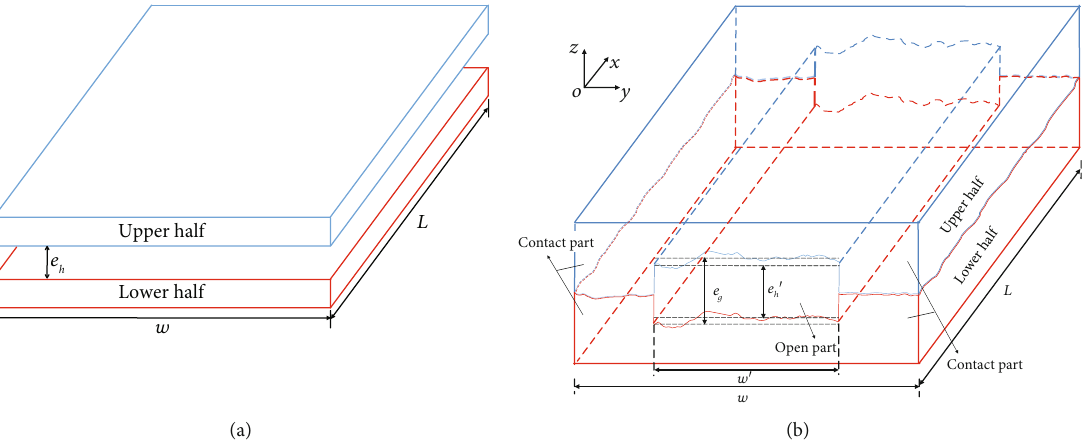
Figure 15: (a) The smooth parallel-plate model; (b) the modi fi ed smooth parallel-plate model developed in this